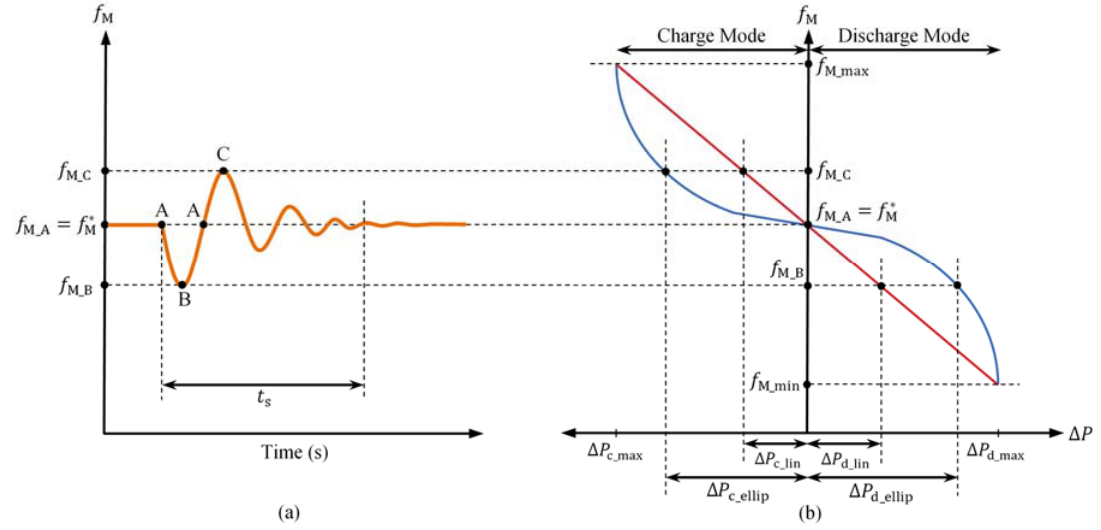
Figure 3. ( a ) Frequency deviations of the AC ‐ bus during abnormal conditions, and ( b ) corresponding linear (red line) and PLE (blue line) P ‐ f characteristics.